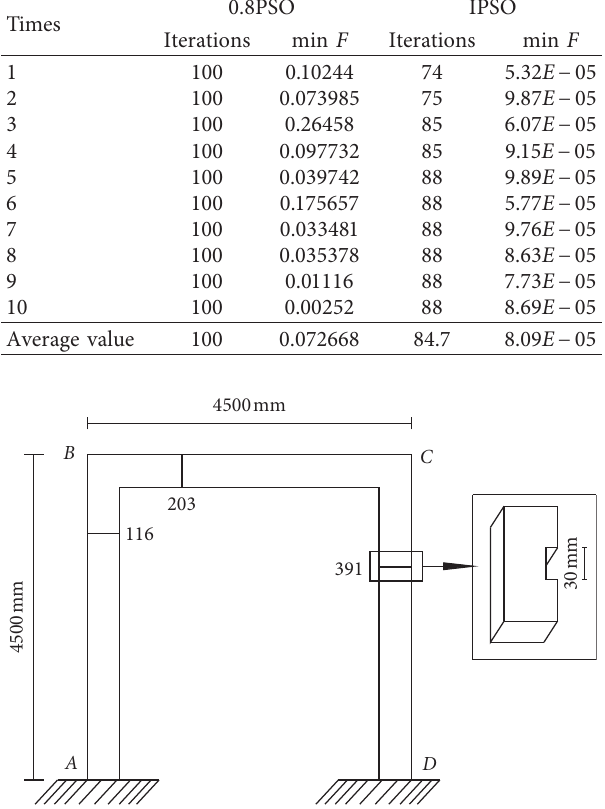
Figure 14: Frame structure with